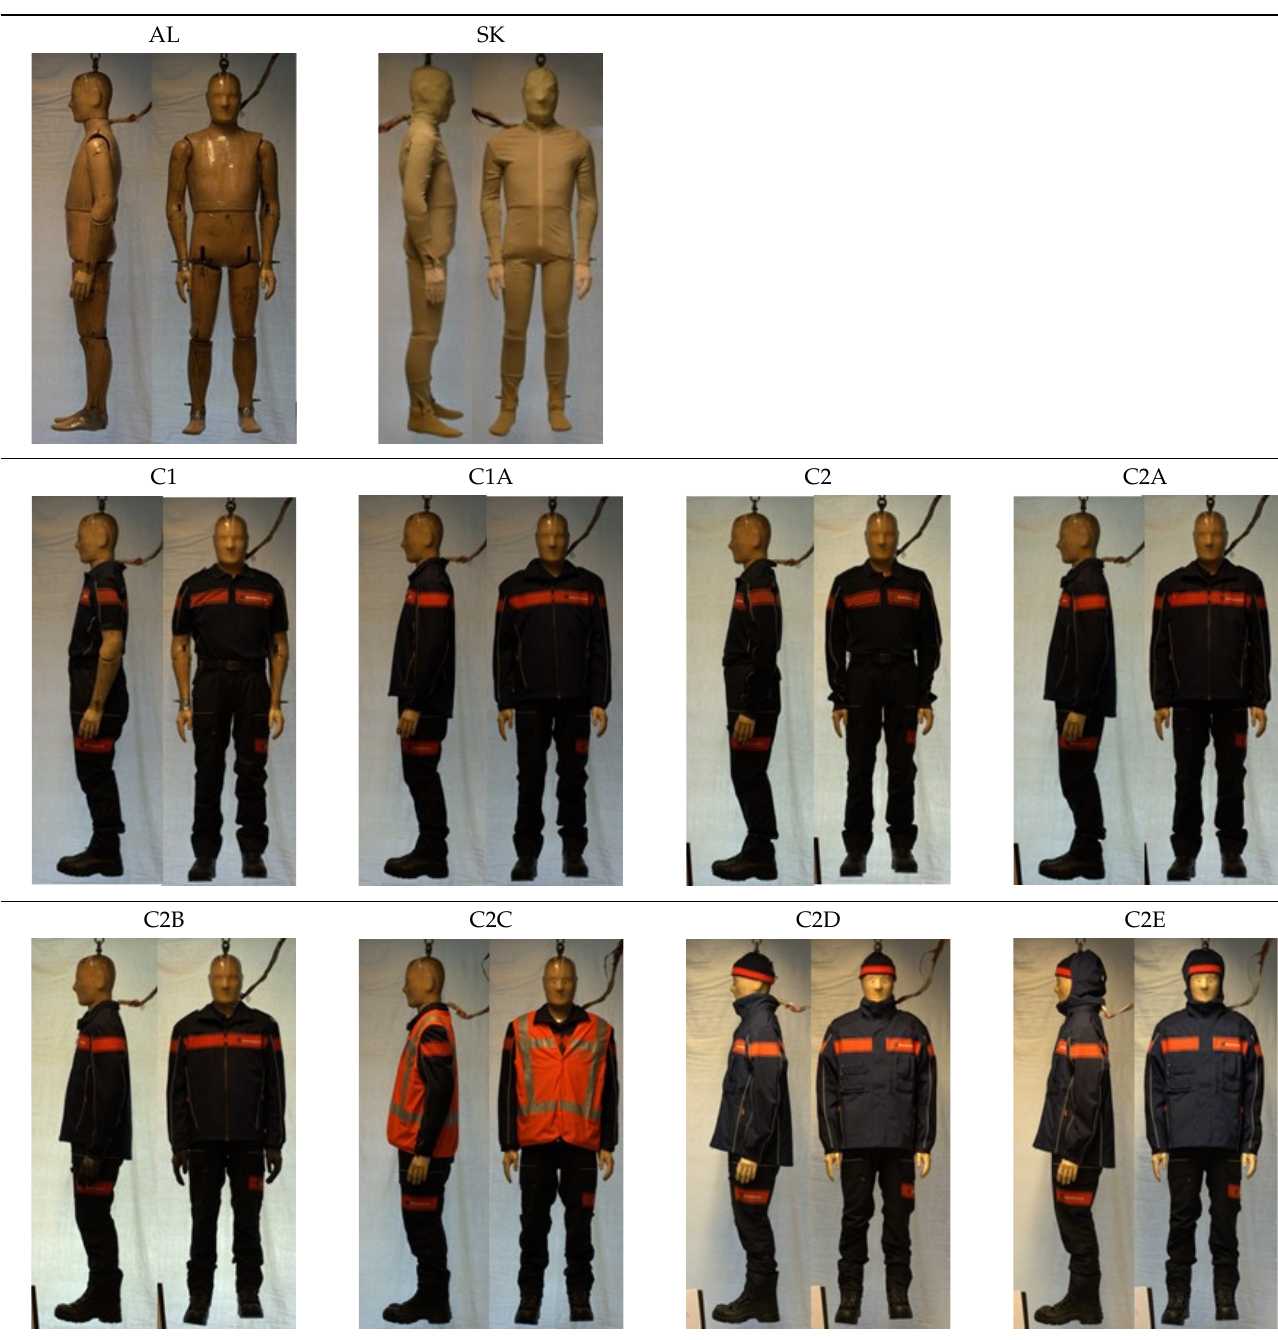
Table 3. Images of the tested clothing ensembles (for properties and composition, see Table 2).